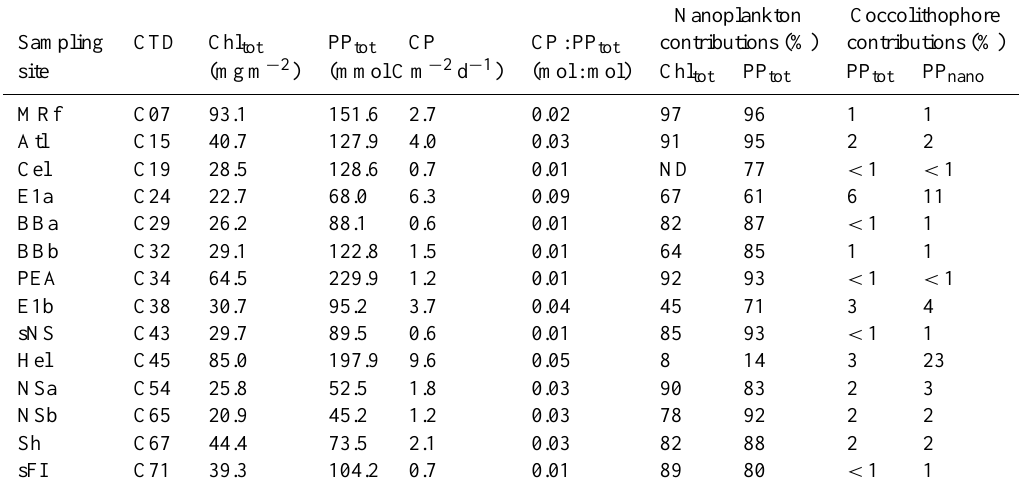
Table 2. Euphotic zone integrals of total chlorophyll (Chl tot ), total primary production (PP tot ), calcite production (CP), ratio of calcite production to primary production (CP:PP), nanoplankton contributions to Chl tot and PP tot and coccolithophore contributions to PP tot and PP nano .